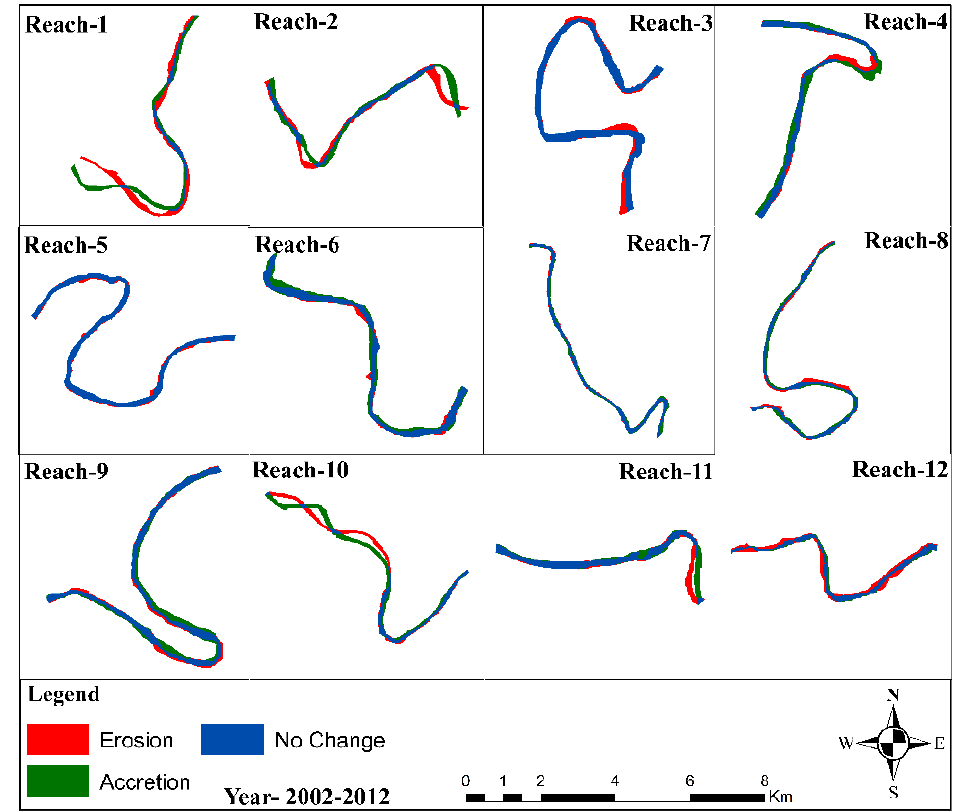
10 Figure 8. Erosion, accretion, and unchanged area at various reaches (1–12) between 1992 and 2002.